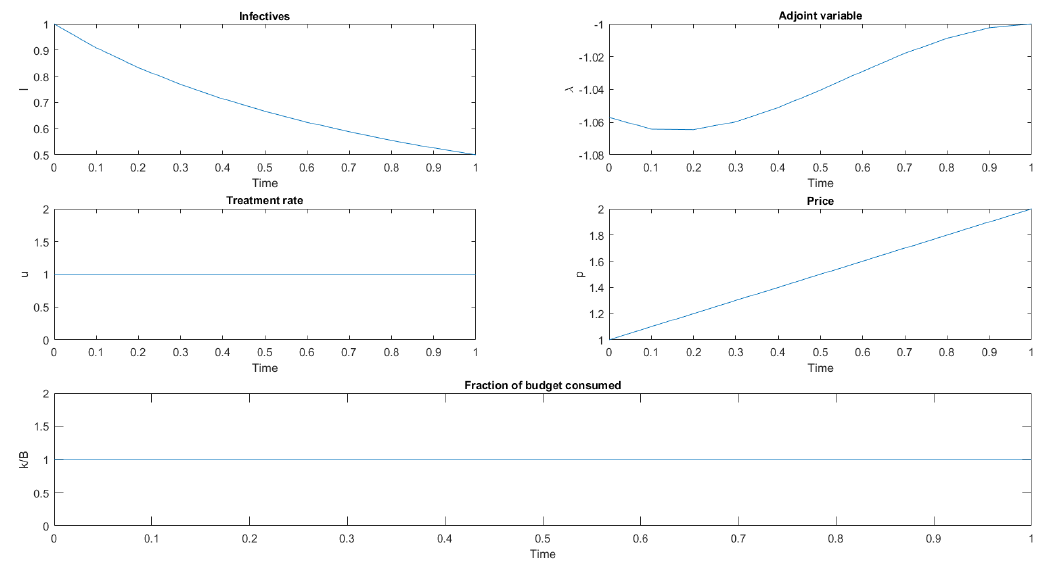
Figure 2. Cooperative solution. Quadratic cost. B =